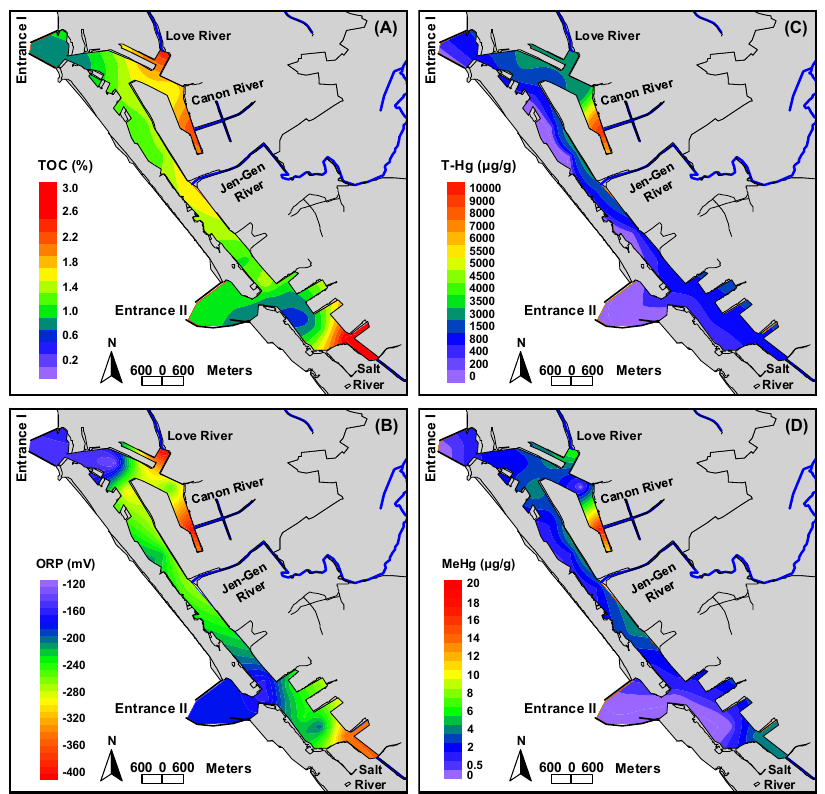
Figure 3. The distributions of ( A ) TOC content, ( B ) ORP, ( C ) T ‐ Hg, and ( D ) MeHg concentrations in the sediments of Kaohsiung Harbor.